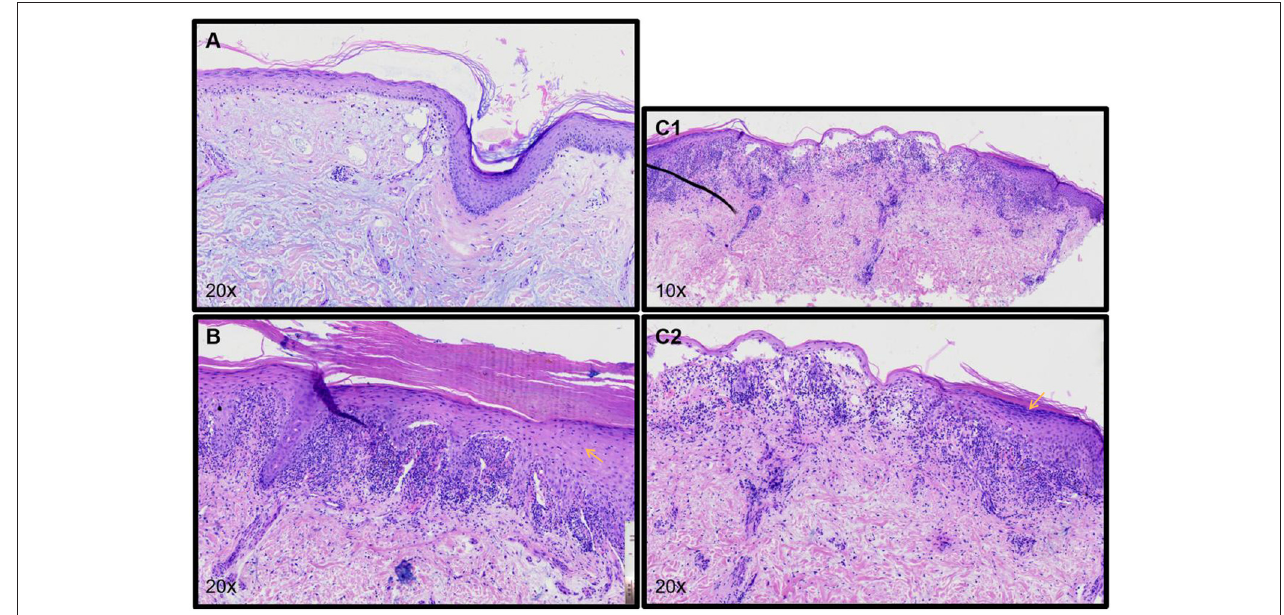
FIGURE 3 | (A) Pathology of the scalp shows atrophy of the epidermis, hair follicle angle plug, liquefaction, and degeneration of basal cells, low infiltration of lymphocytes around the superficial dermis vessels, reduction of appendages, and deposition of a large amount of mucoprotein in the dermis. (B) Pathology of the upper arm shows hyperkeratosis of the epidermis, wedge-shaped thickening of the granular layer, liquefaction of basal cells, zonal infiltration of lymphocytes in the superficial dermis, and formation of epidermal fissures. (C1,C2) Pathology of the back of the patient’s hand shows hyperkeratosis of the epidermis, wedge-shaped thickening of the granular layer, liquefaction of basal cells, zonal infiltration of lymphocytes in the superficial dermis, and subepidermal blisters.